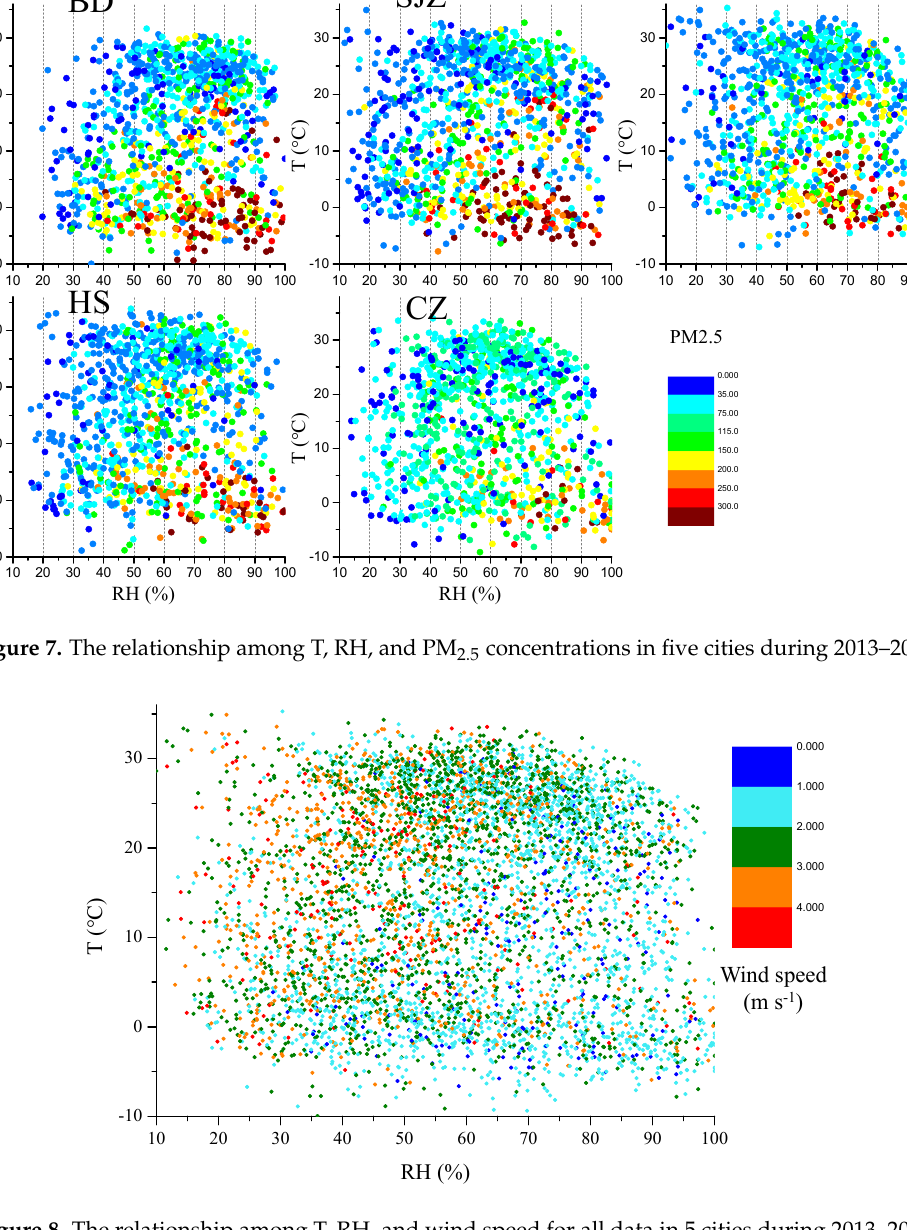
Figure 8. The relationship among T, RH, and wind speed for all data in 5 cities during 2013–2015. The PM 2.5 concentrations of target cities are not only decided by local emissions, but also by the surrounding pollution regions. Maps of wind rose and the relationships between the 6-h average PM 2.5 concentration, wind speed, and wind direction in the study cities are presented in Figures 5 and 9 to investigate the regional influence. The lowest wind speeds were found in SJZ, HD, and HS, epically during winter and autumn. The wind speeds associated with southeasterly to southwesterly winds were usually very low, except for HD, HS, and CZ in spring and summer. The strong northwesterly winds were mostly in BD and only occurred during summer in SJZ and CZ. At the remaining sites, northwesterly winds were weak. High PM 2.5 values were associated with weak winds, less than 2 m s − 1 , which revealed higher local emissions. Low PM 2.5 values were associated with winds from the northwest except during winter. In most cities, PM 2.5 concentration increased with elevated wind speed in different wind directions, which is indicative of the influence of the regional transport from the surrounding polluted regions. The regional transport is discussed in detail in the next